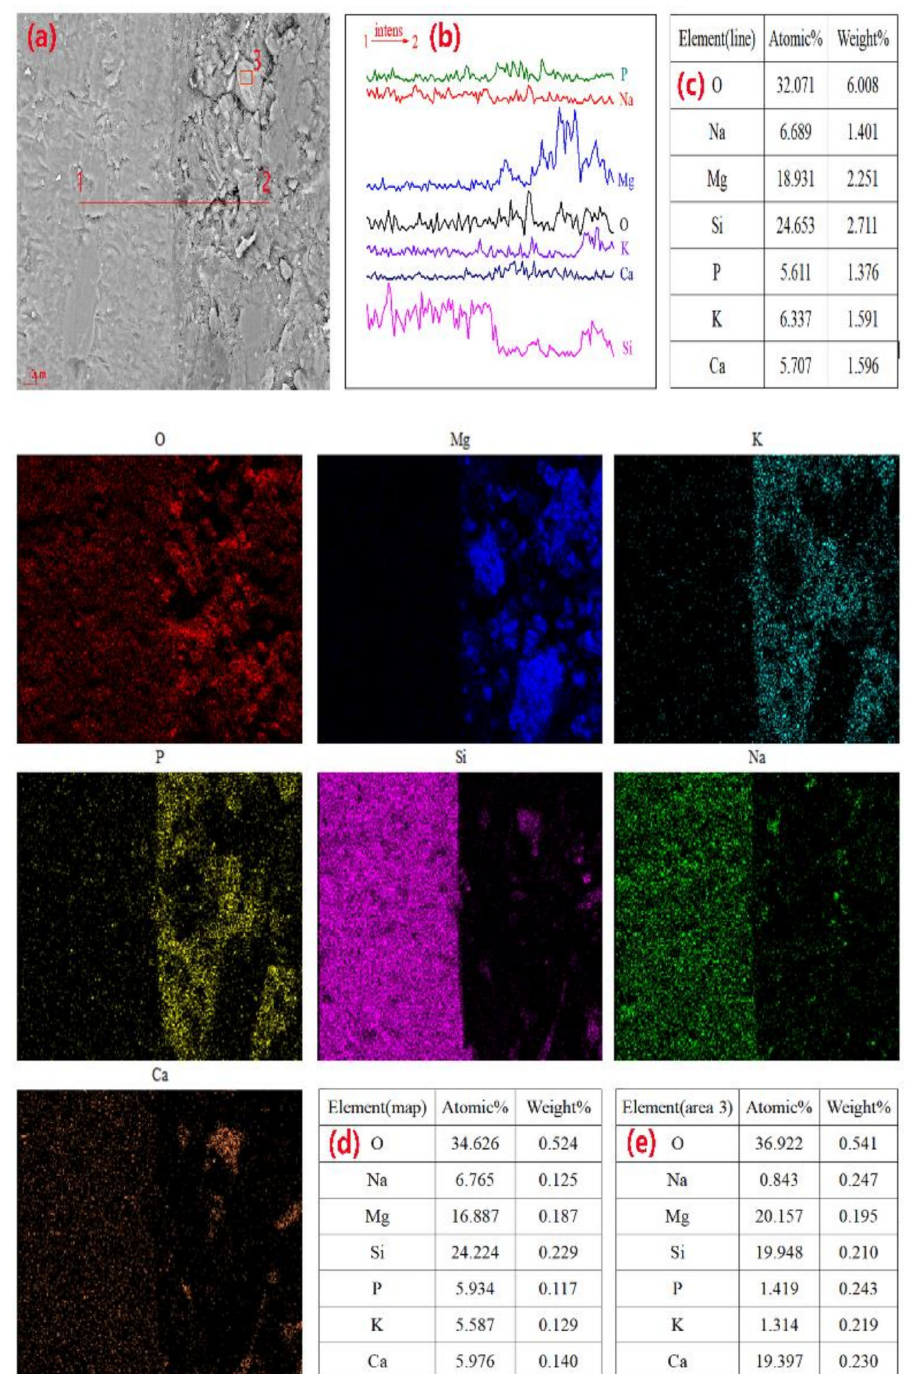
Figure 13. SEM images and element maps along lines 1–2 of the MKPC pastes cured after 7 days: M/P ratio = 2:1 and 40 wt.% content of glass fragments, ( a ) SEM image; ( b ) Intensity of each element distribution along line 1-2; ( c ) EDS elemental distribution along lines 1–2; ( d ) EDS elemental maps; ( e ) EDS elemental area